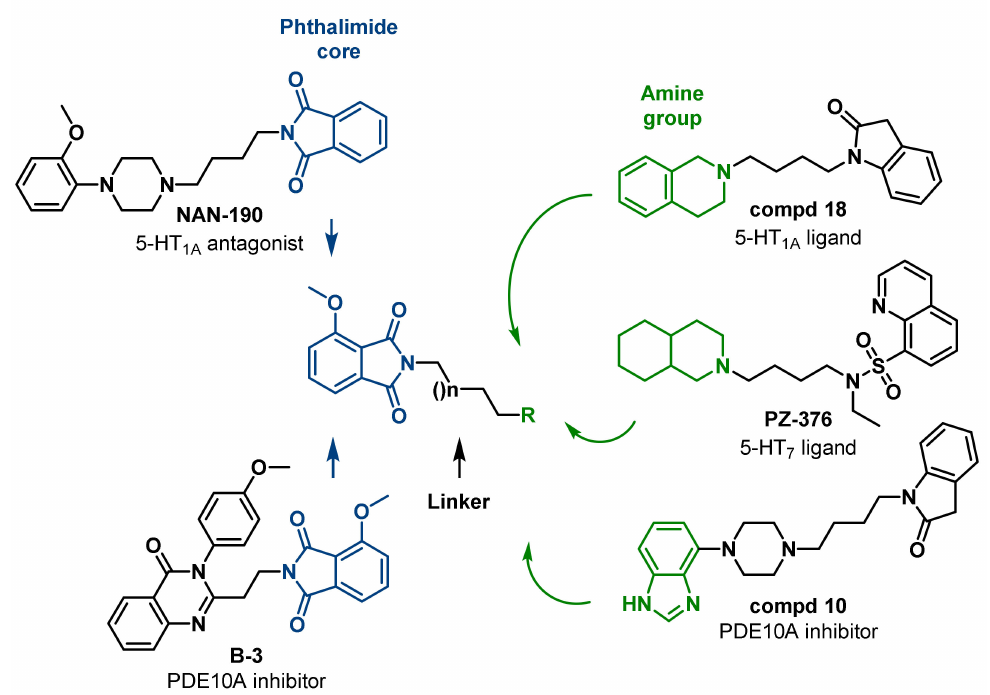
Figure 2. General structure of novel compounds 3 – 23 , designed based on potent phosphodiesterase 10A (PDE10) inhibitors and active serotonin receptor ligands [20,25,26,28–30]. The phthalimide cores and amine groups are highlighted in blue and green,